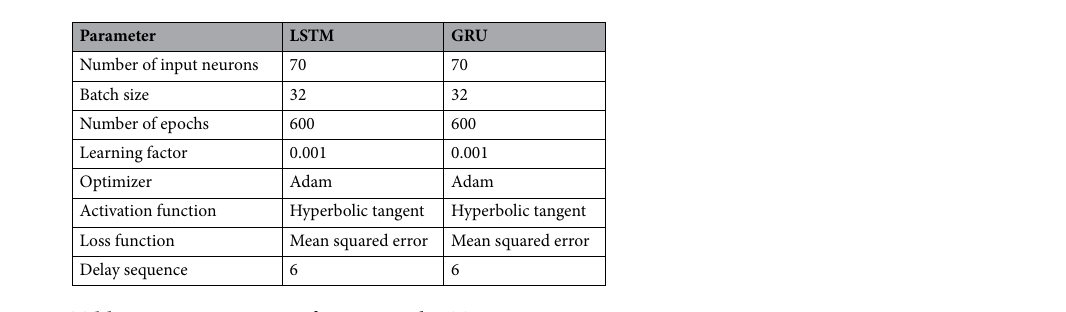
Table 2. Parameter setup for GRU and LSTM